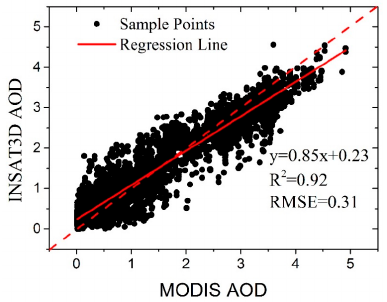
Figure 4. Cross validation of retrieved INSAT 3D AOD and MODIS Deep-Blue AOD: solid line denotes the linear regression line while dash line denotes the 1-1 line.